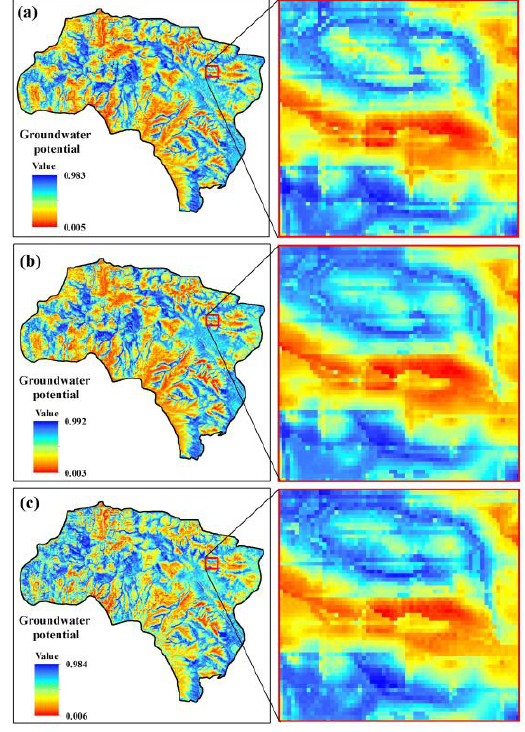
Figure 6. Groundwater potential maps produced by QUEST and three sample datasets ( a – c ).